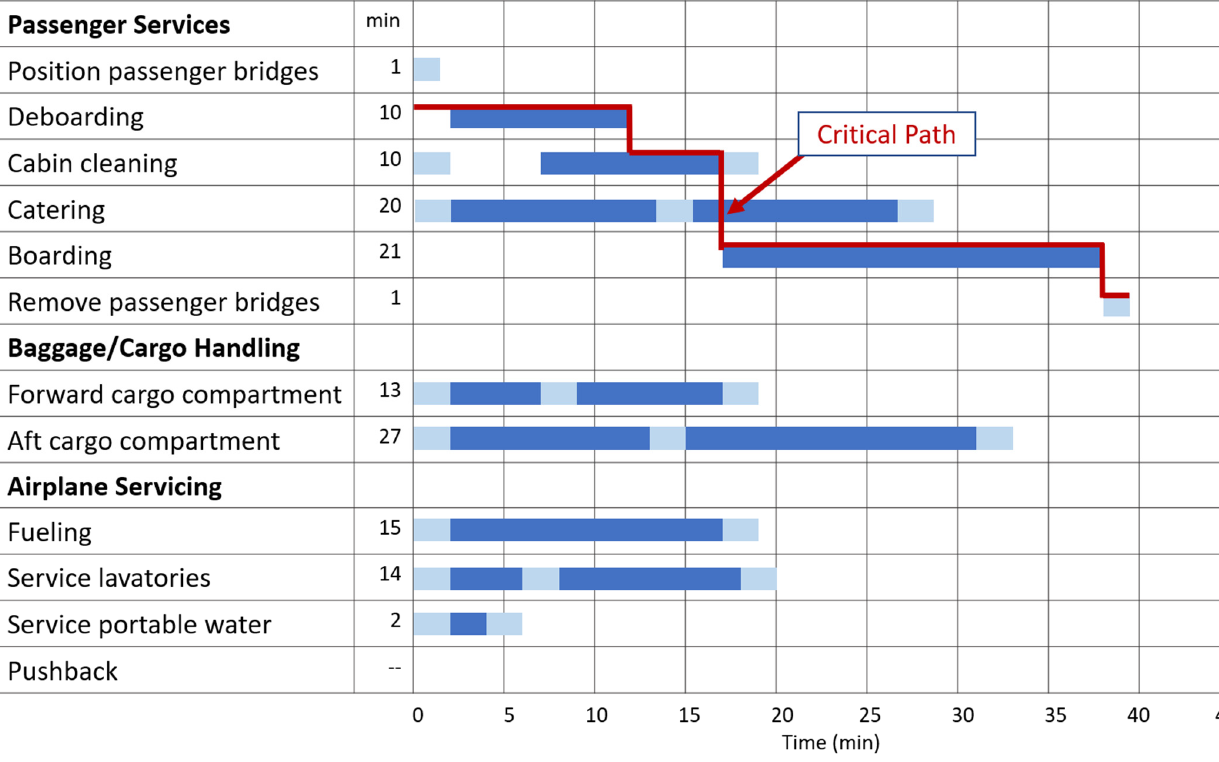
Figure 3. Turnaround Gantt-chart for a typical single aisle aircraft. Source: inspired and adapted from Fuchte 2014, p. 6 [23].